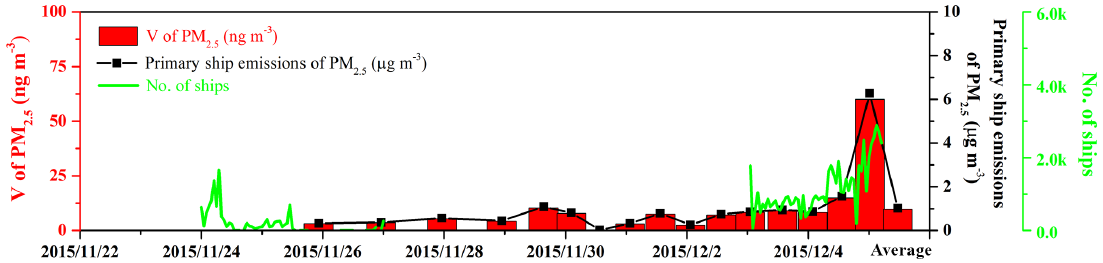
Figure 7. Time series of V concentration (read column), estimates of primary PM 2 . 5 from ship emissions, and number of ships distributed in the Yangtze River channel during the